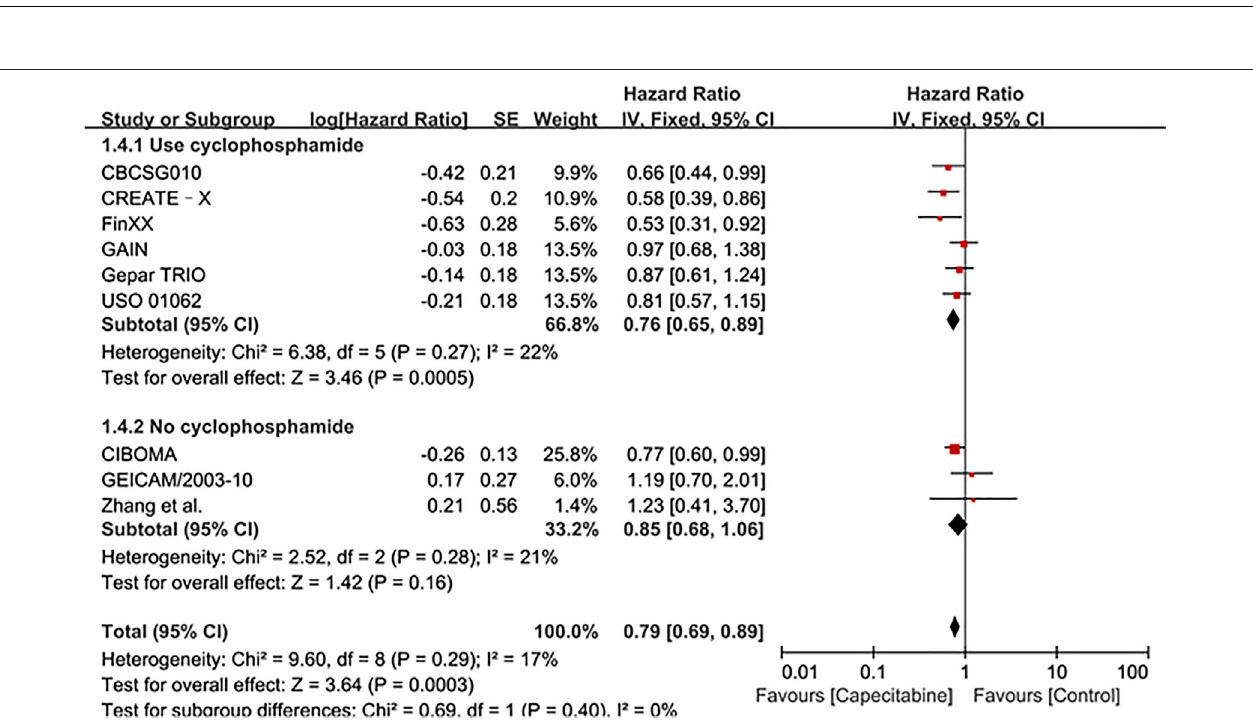
FIGURE 3 | Subgroup analysis of the effect of capecitabine and cyclophosphamide combined with chemotherapy on DFS in TNBC patients.